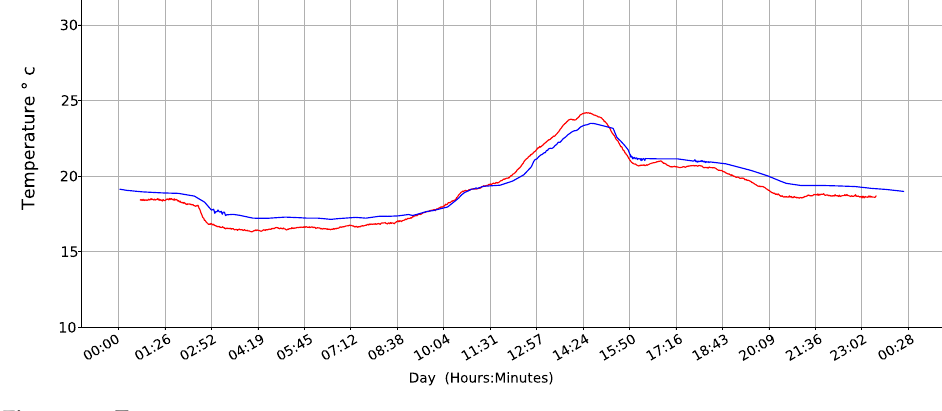
Figure 20. Temperature curve.